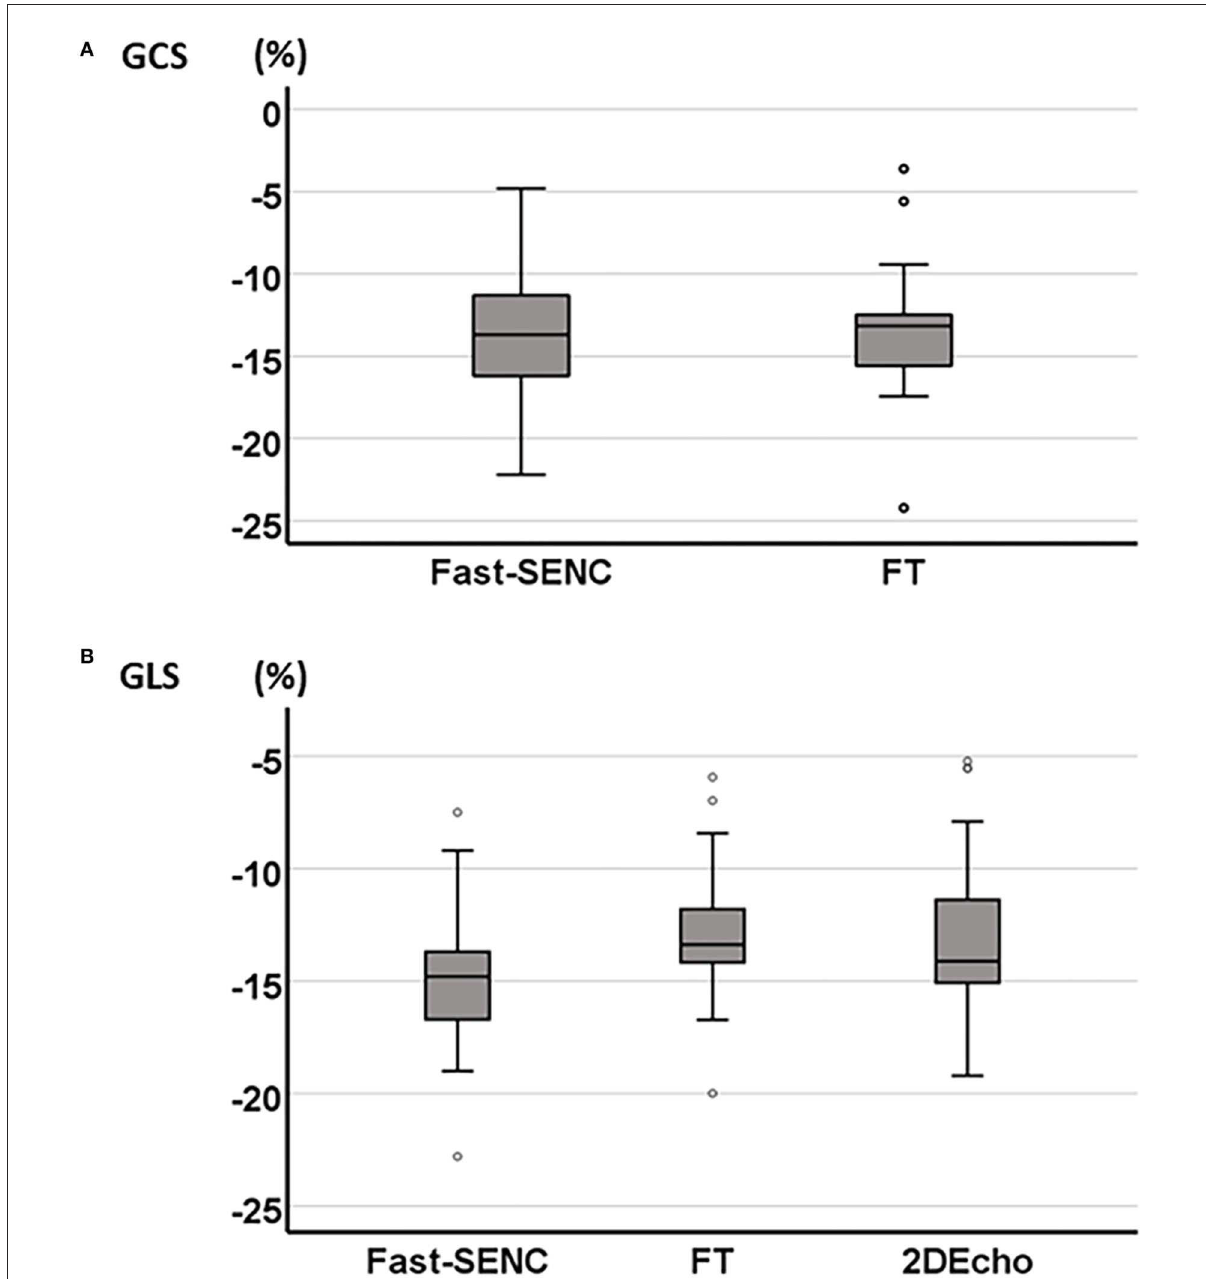
FIGURE2 Boxplot of mean GCS derived from fast-SENC and FT (A) and mean GLS derived from fast-SENC, FT, and 2DEcho (B)